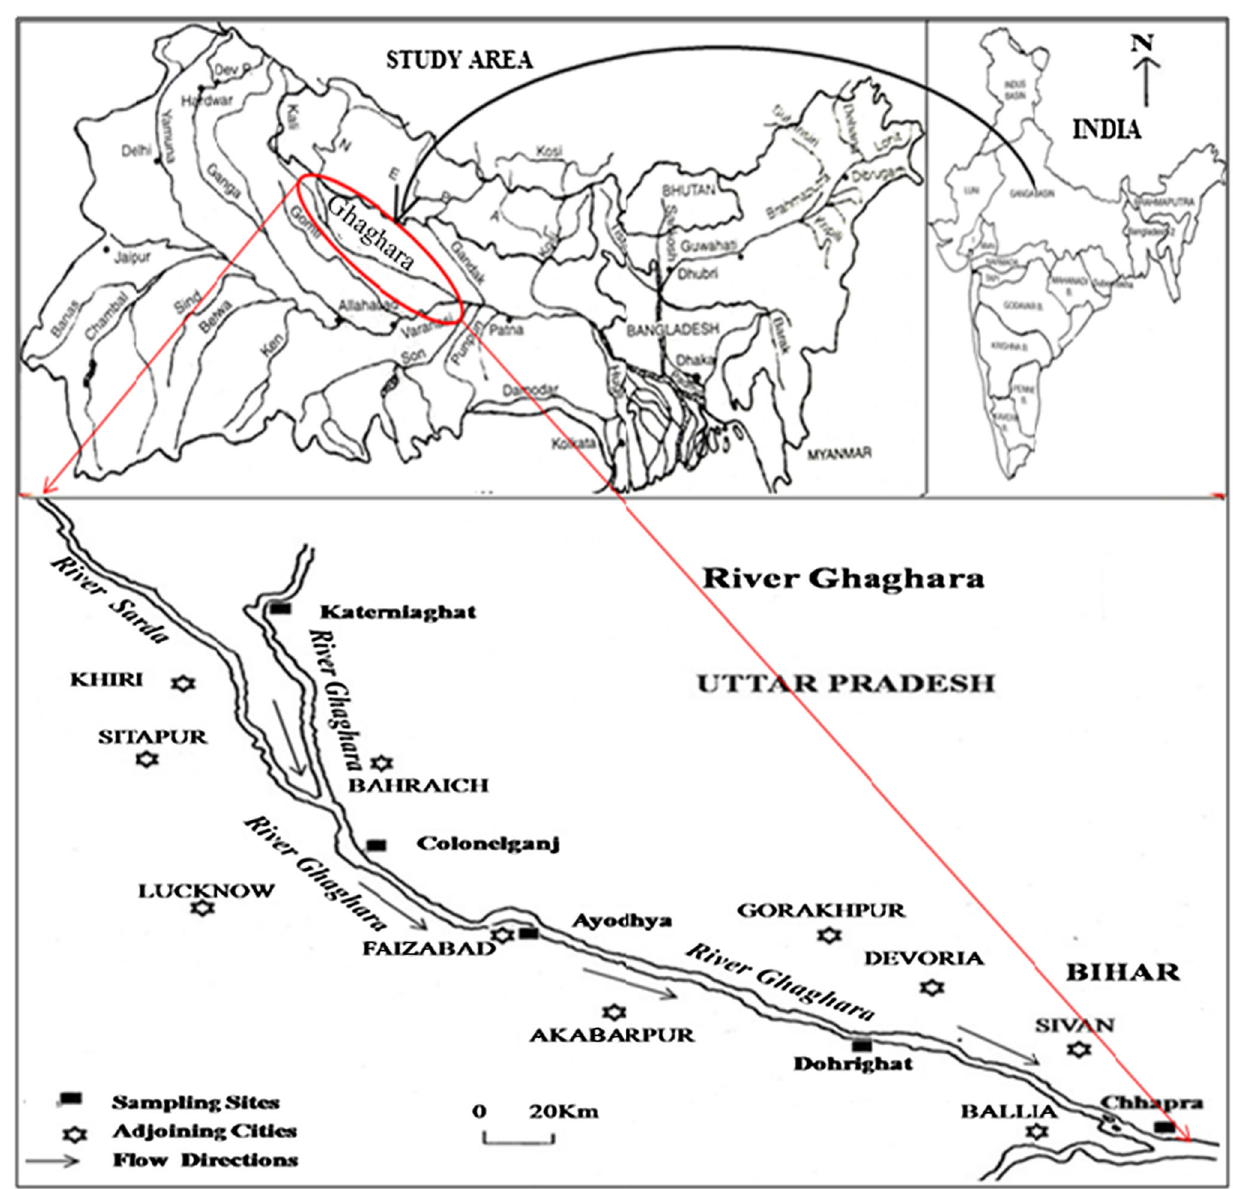
Fig. 1 Sampling stations of the River Ghaghara with the adjoining cities